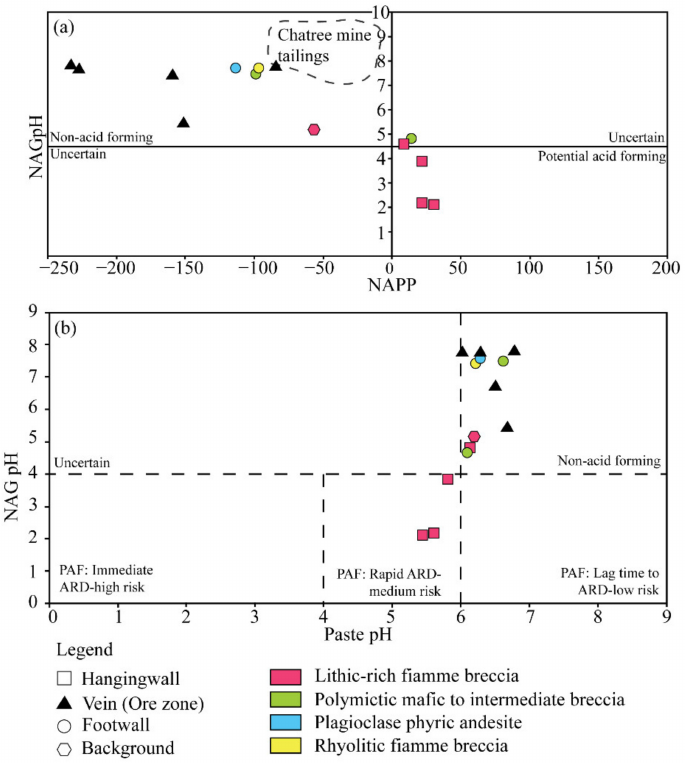
Figure 7. Classification of the ARD potential of the representative ore and host rock samples from the H ore lens of the Chatree deposit. ( a ) Plots using the classification scheme of Smart et al. [4] showing all of the lithic-rich fiamme breccia samples plot on the PAF field or on a boundary with UC field, whereas plots of all the rest samples are on NAF field except one footwall sample plotted on UC field. The data field of Chatree mine tailings is from Changul et al. [13]. ( b ) Plots using the classification scheme of Price [42] showing three of four hanging wall lithic-rich fiamme breccia samples plotted on the PAF’s rapid ARD-medium risk field. In contrast, all the remaining samples are placed on the NAF